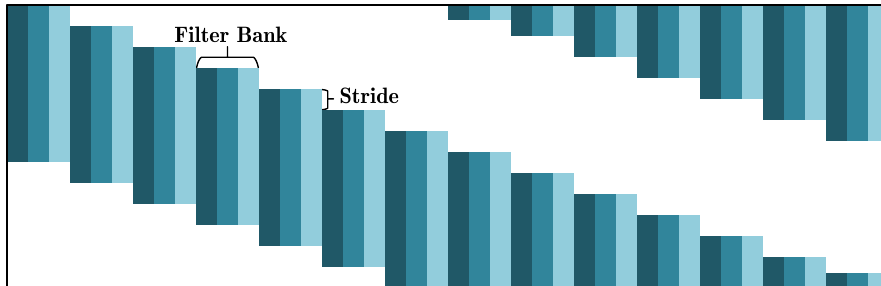
Figure 6. Convolution matrix with sparse structure. Here, the columns of the filter bank correspond to the filters used for spatial filtering, e.g., three filters in this example, and the stride is associated with the displacement in the convolution process. See more details in